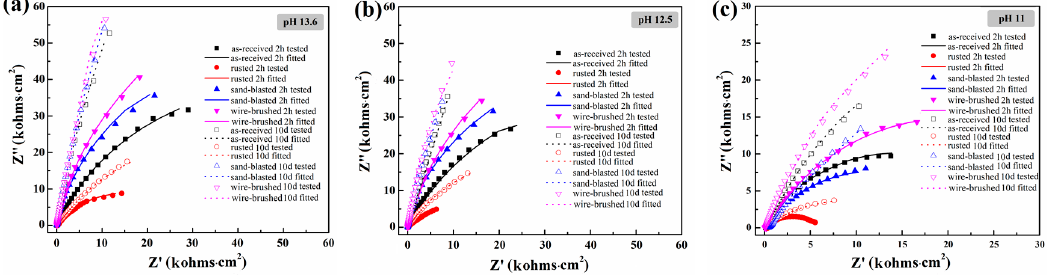
Figure 3. Electrochemical impedance spectroscopy (EIS) Nyquist plots of the rebar in Cl − -free simulated concrete pore solutions (SCPS) of different alkalinity: ( a ) pH 13.6, ( b ) pH 12.5, and ( c ) pH 11.